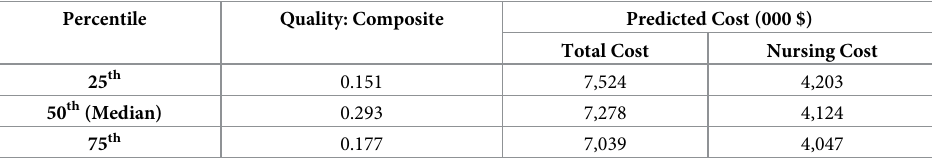
Table 5. Cost predictions at quartile measures of quality: Composite measure of